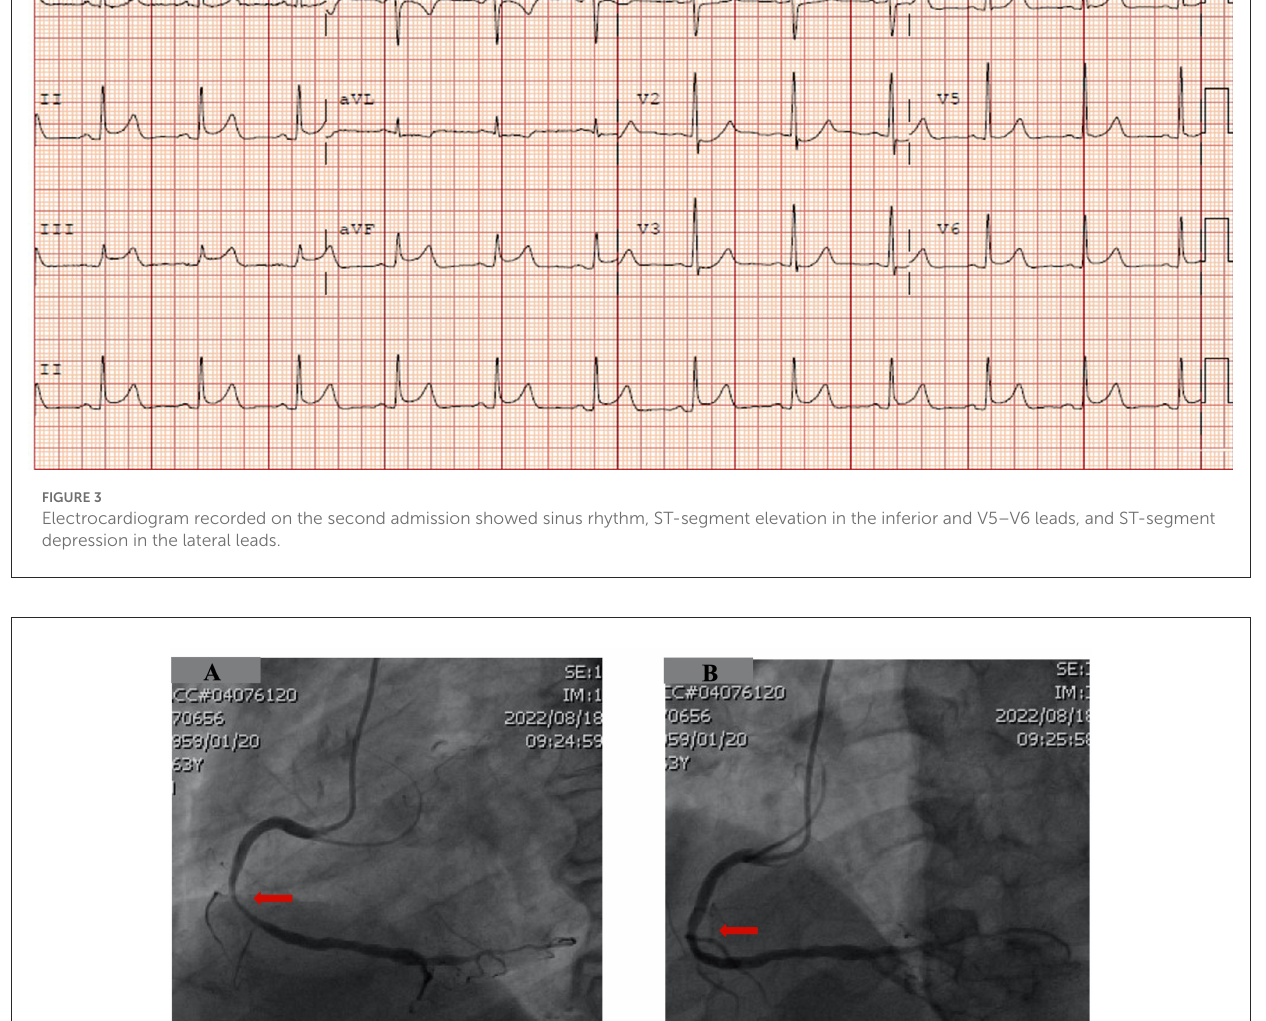
were completely normal. Intravenous injections of nitroglycerine and diltiazem were administrated as well. His ECG monitor indicated no ventricular arrhythmia during hospitalization. Taking all these findings together, we attributed the patient’s symptoms, namely, angina, syncope, and ventricular arrhythmia, to coronary artery spasm and implanted an ICD for secondary prevention of SCD (Supplementary Figure 2). He was discharged on diltiazem and isosorbide mononitrate as well as aspirin and rosuvastatin. During the 3 months follow-up, the patient had been free of chest discomfort, dyspnea, or syncope, and ICD interrogation showed no ventricular tachycardia or ventricular